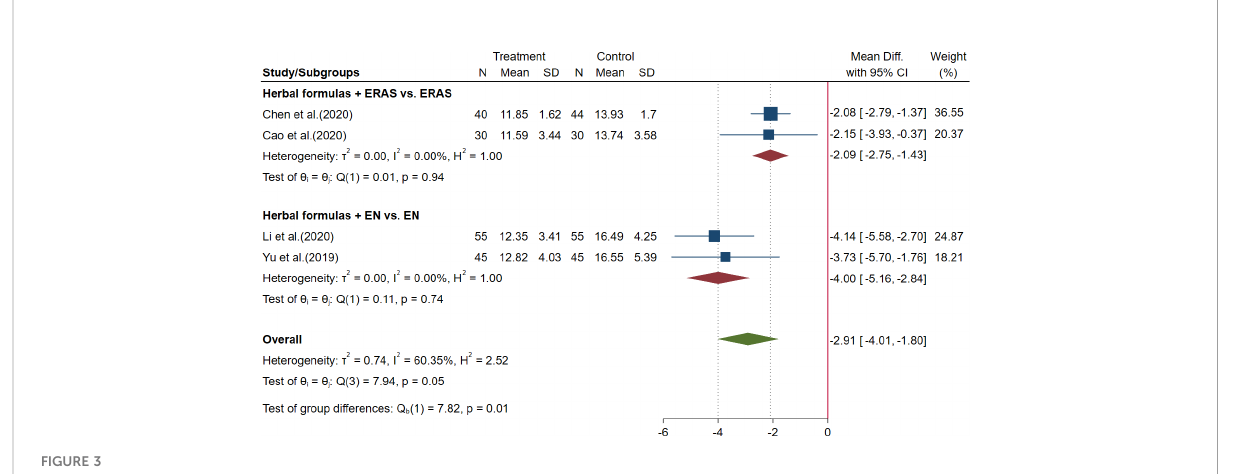
FIGURE 3 Forest plot of duration of hospitalization in perioperative gastric cancer